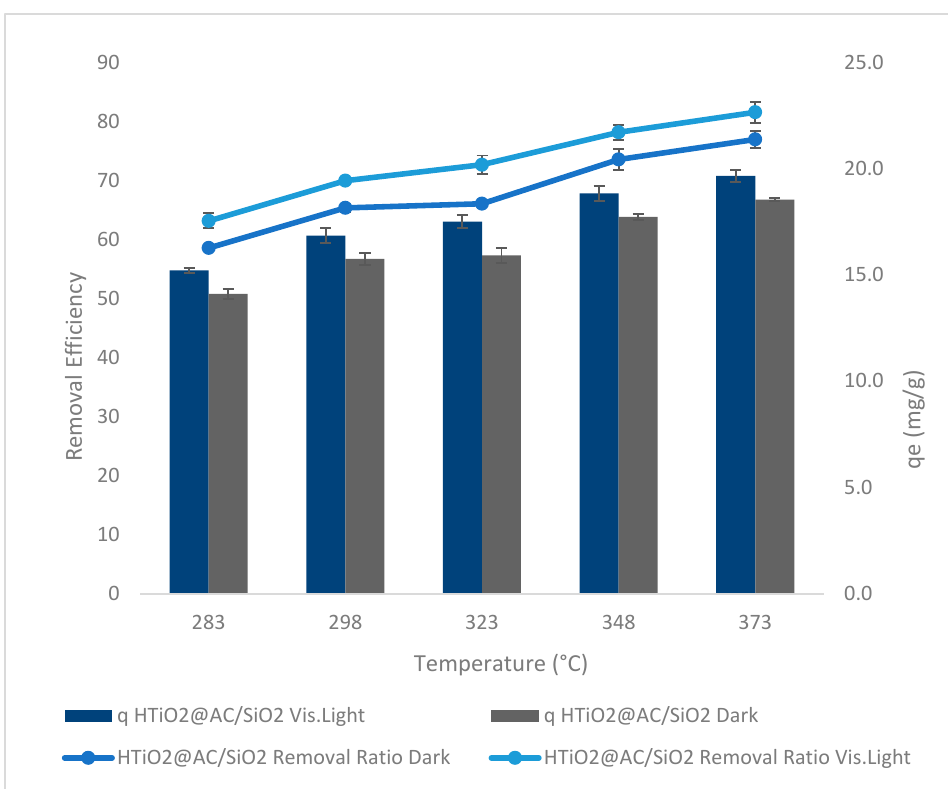
Figure 10. Temperature versus removal efficiency using HTiO 2 @AC/SiO 2 .